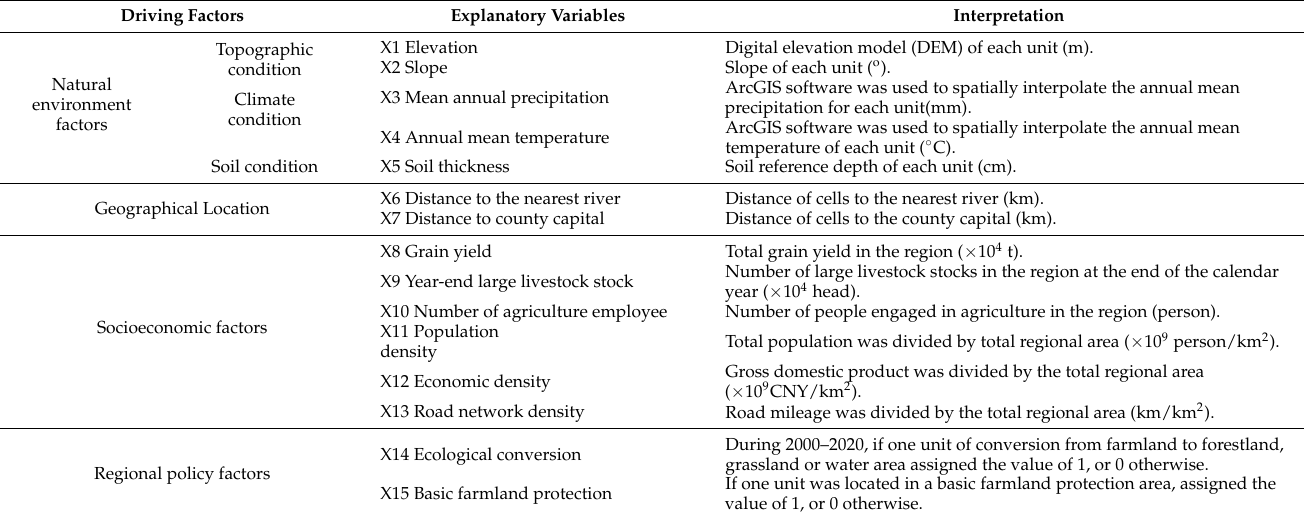
Table 4. Driving factors of land-use structure change in the